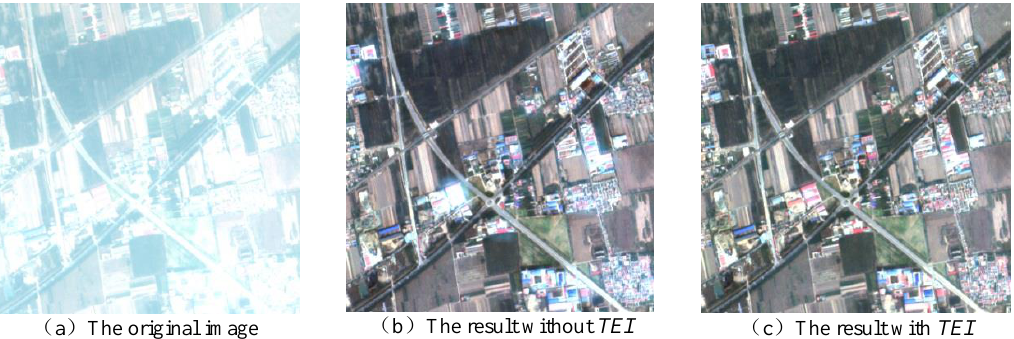
Figure 7. The correction results of the image before and after the introduction of T E